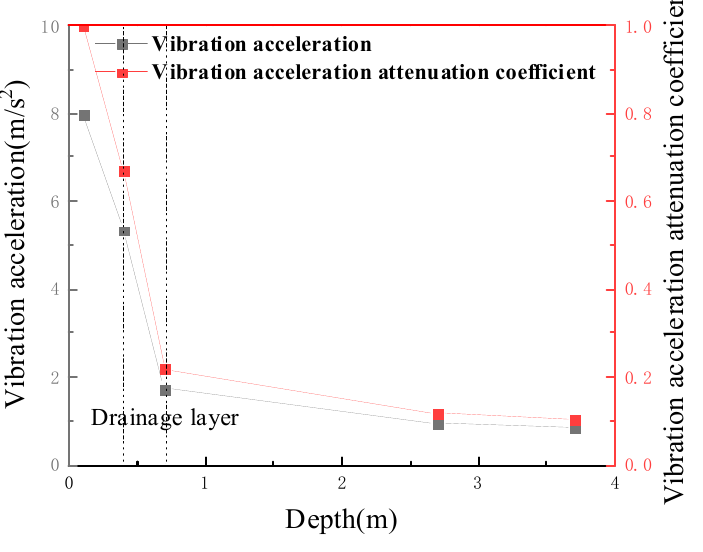
Figure 15. Variation law of vibrational acceleration with depth.